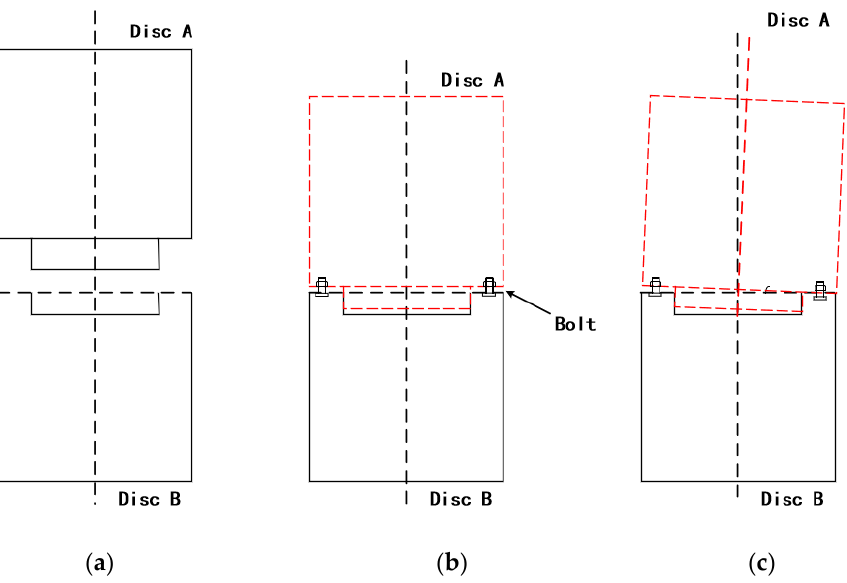
Figure 4. Rotor assembly diagram. ( a ) Before assembly; ( b ) Before bolt tightening; ( c ) After bolt tightening.